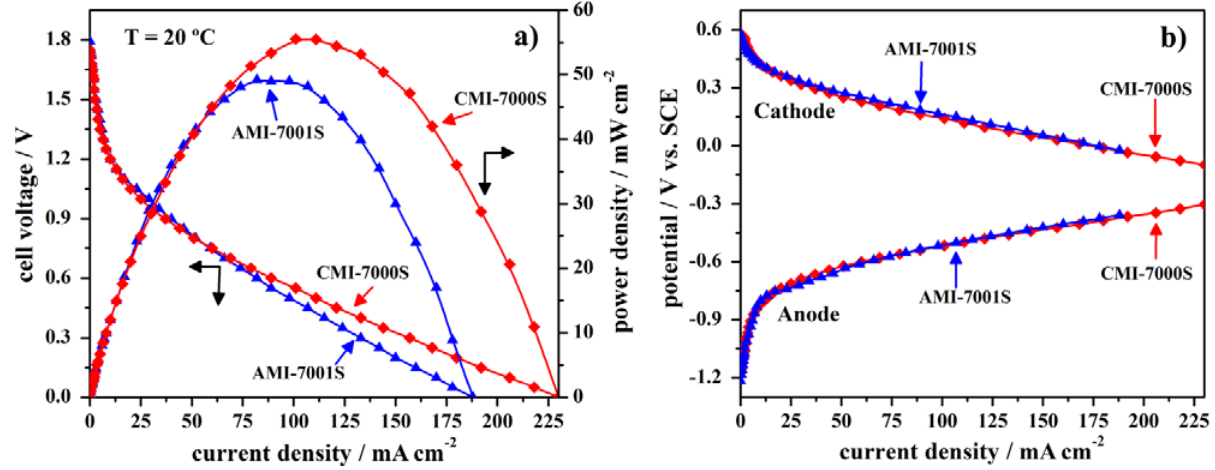
Figure 3. Polarization curves for DBPFCs employing the two tested membranes, including ( a ) cell voltage and power density curves and ( b ) the corresponding electrodes’ potentials.